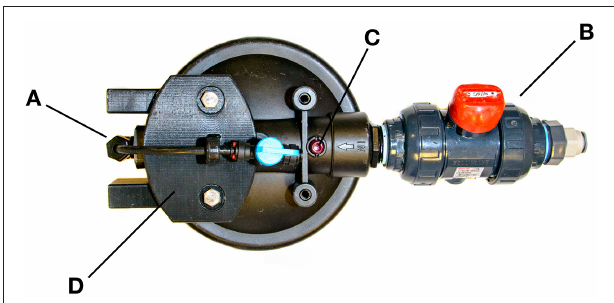
FIGURE 2 | The SubCAS chamber cap, showing: (A) 2.5cm threaded port, reduced to connect 6mm diameter water supply tubing and an isolation valve, (B) 2.5cm threaded port with true-union valve and connection for 12mm water discharge tubing (C) the pressure-relief button, which has been disabled, and (D) the custom 3-D printed plastic shield that protects the tubing and fittings. Note the reversed flow direction through the cap inlet and outlet, and the modified true-union valve handle, as described in the text.